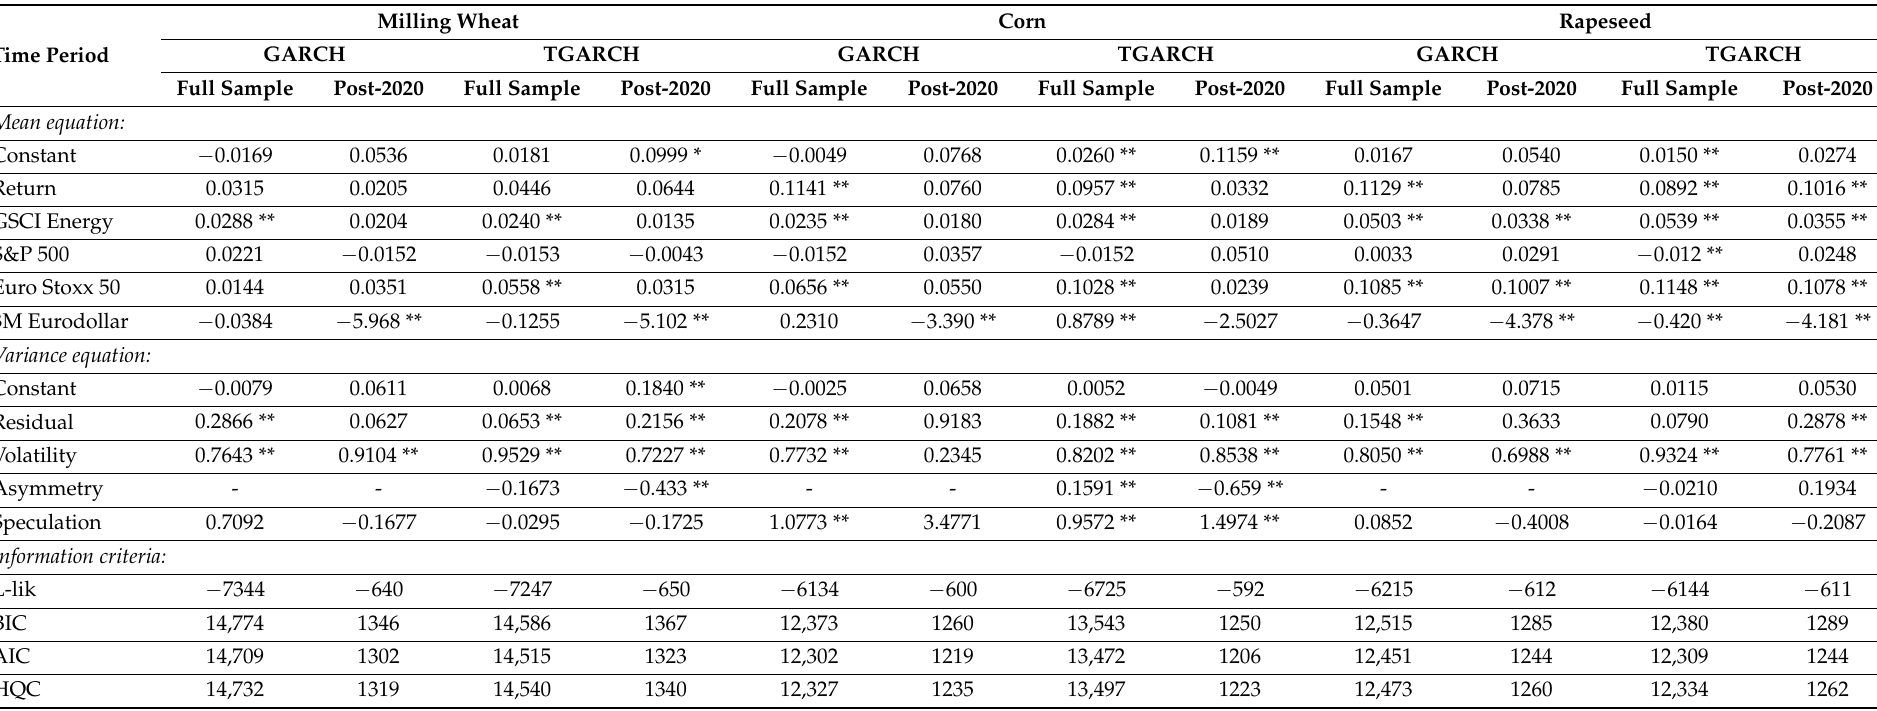
Table A1. Estimates of GARCH agricultural commodity-return models with additional variables using Framework I without a month’s